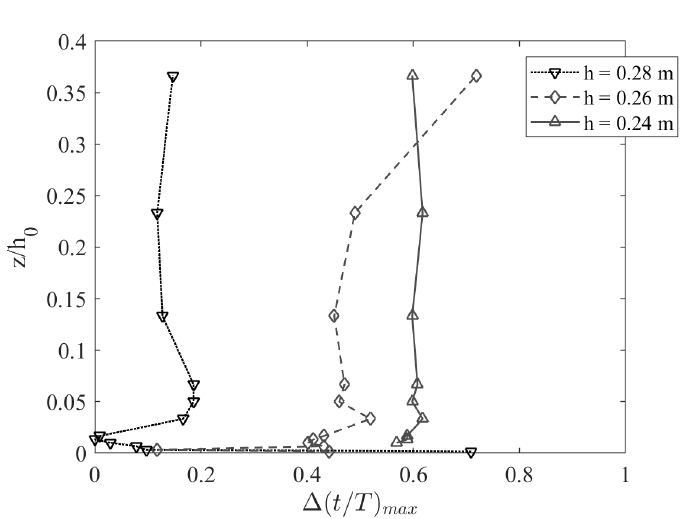
Figure 10. Phase shift between maximums of phase-averaged velocities ˜ u and ˜ v